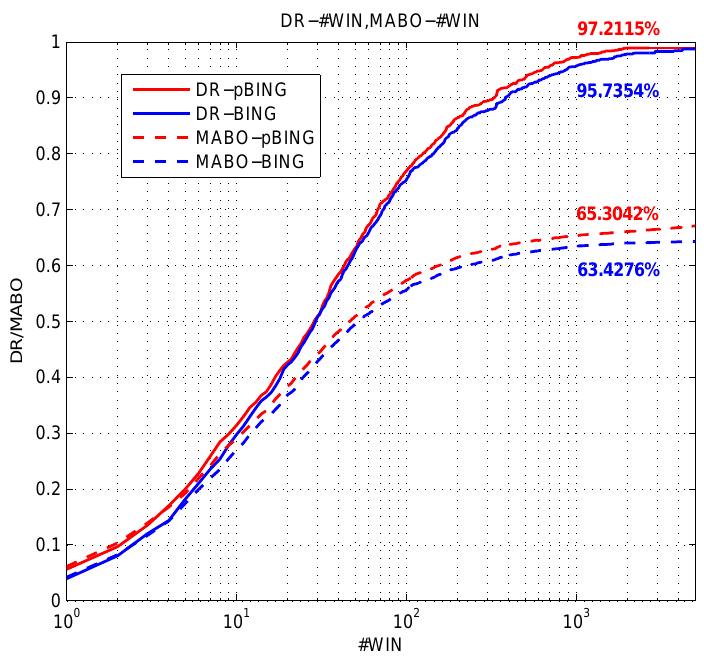
Figure 5. Tradeoff between the number of windows (#WIN) and DR/MABO on the dataset